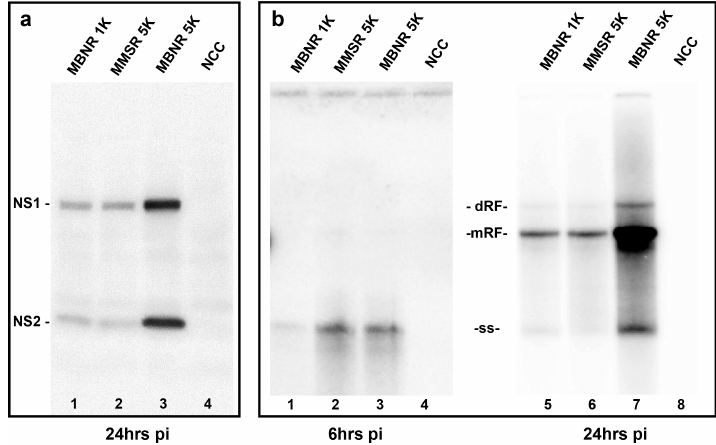
Figure 5. Comparison of non-structural gene expression and viral DNA accumulation. B16F10 cells were infected, as described in the Methods section, with MMSR at 5000 genomes per cell (5K), or with MBNR at 1000 (1K) or 5000 (5K) genomes per cell. ( a ) shows a Western blot of an SDS polyacrylamide gel of NS protein accumulation by 24 h after infection, probed with an antibody raised against the N-terminal region common to all NS1 and NS2 species; ( b ) shows a Southern blot of an agarose gel hybridized with a probe synthesized from the NS1 sequence of MPV1. Intracellular viral DNA was extracted at 6 or 24 h after infection, as described in the Methods section. dRF, mRF and ss denote the migration positions for dimer replicative form, monomer replicative form, and single-stranded viral genomes, respectively. Lanes 1–4 were exposed for ~10 times longer than lanes 5–8.